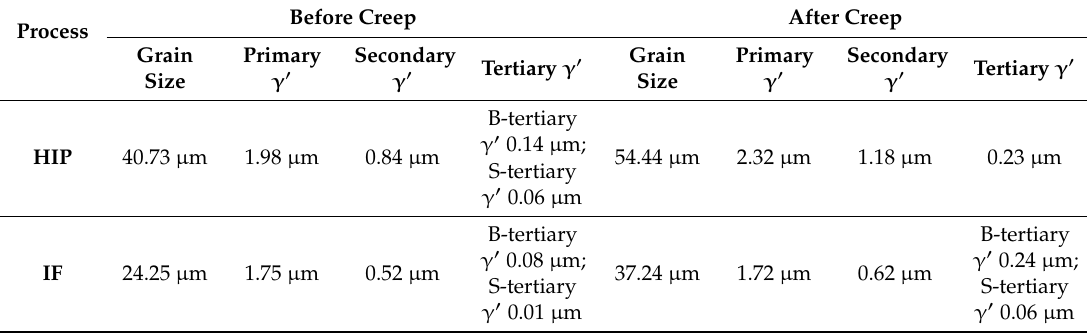
Table 4. Statistics of average grain size and γ (cid:48) precipitate size before and after the creep of FGH100L alloy in di ff erent